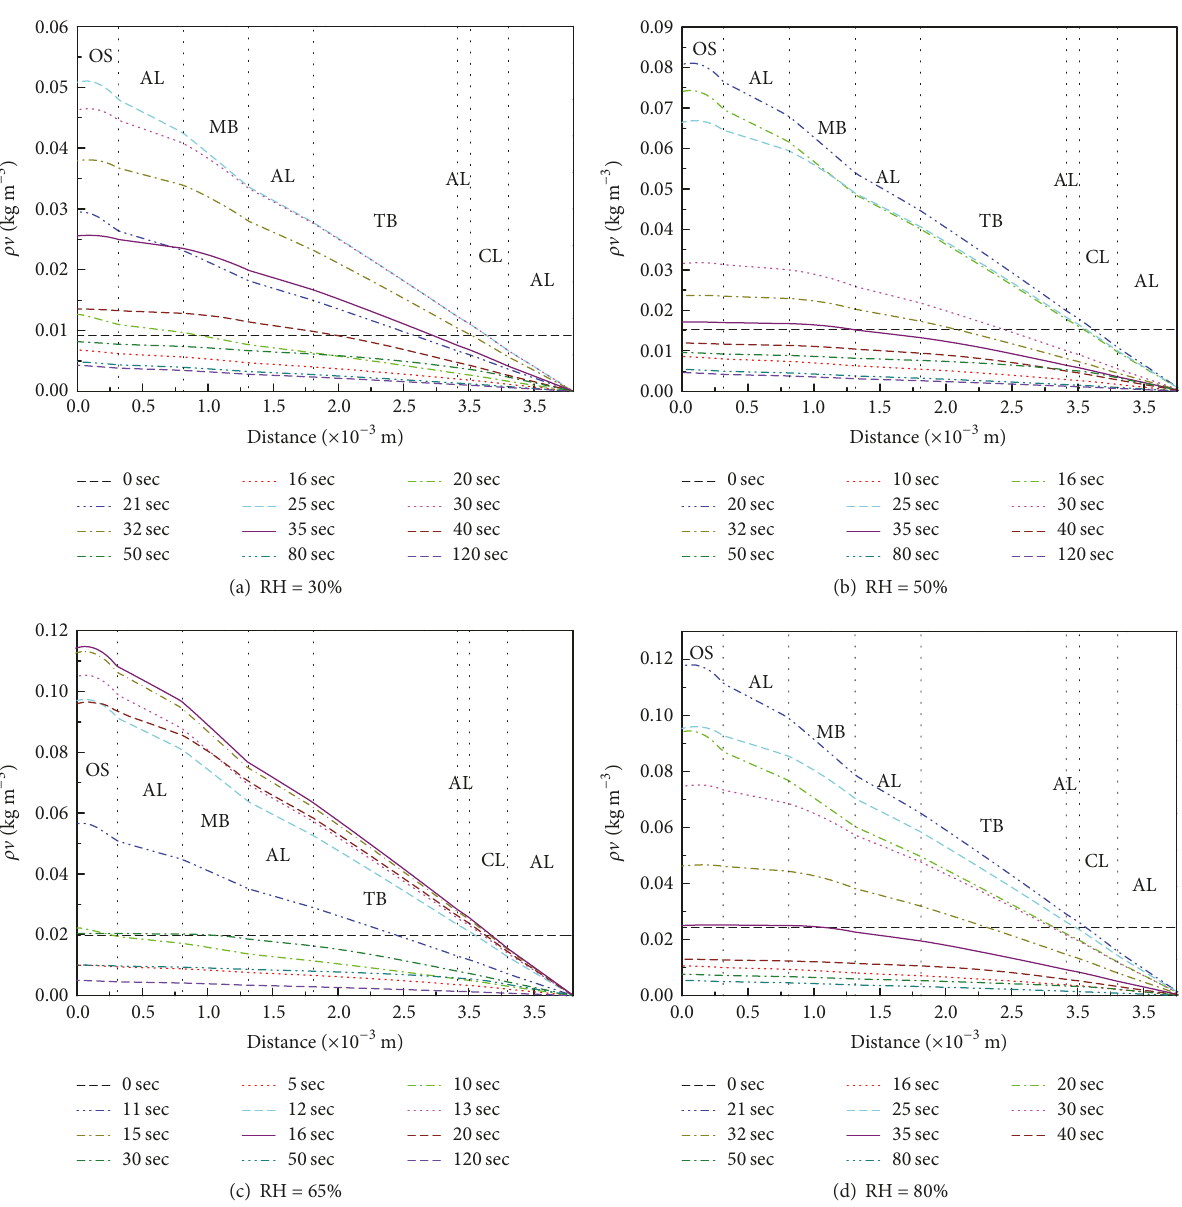
Figure 10: Distributions of water vapor density at different